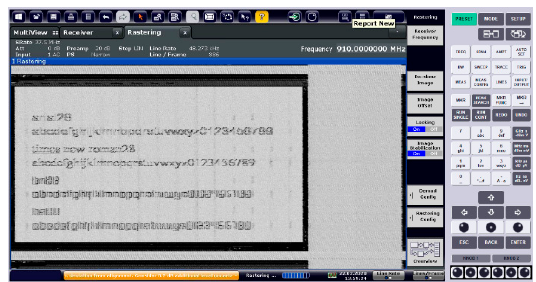
Figure 9. Image recovered when secure symmetrical font was displayed—R&S FSET receiver.